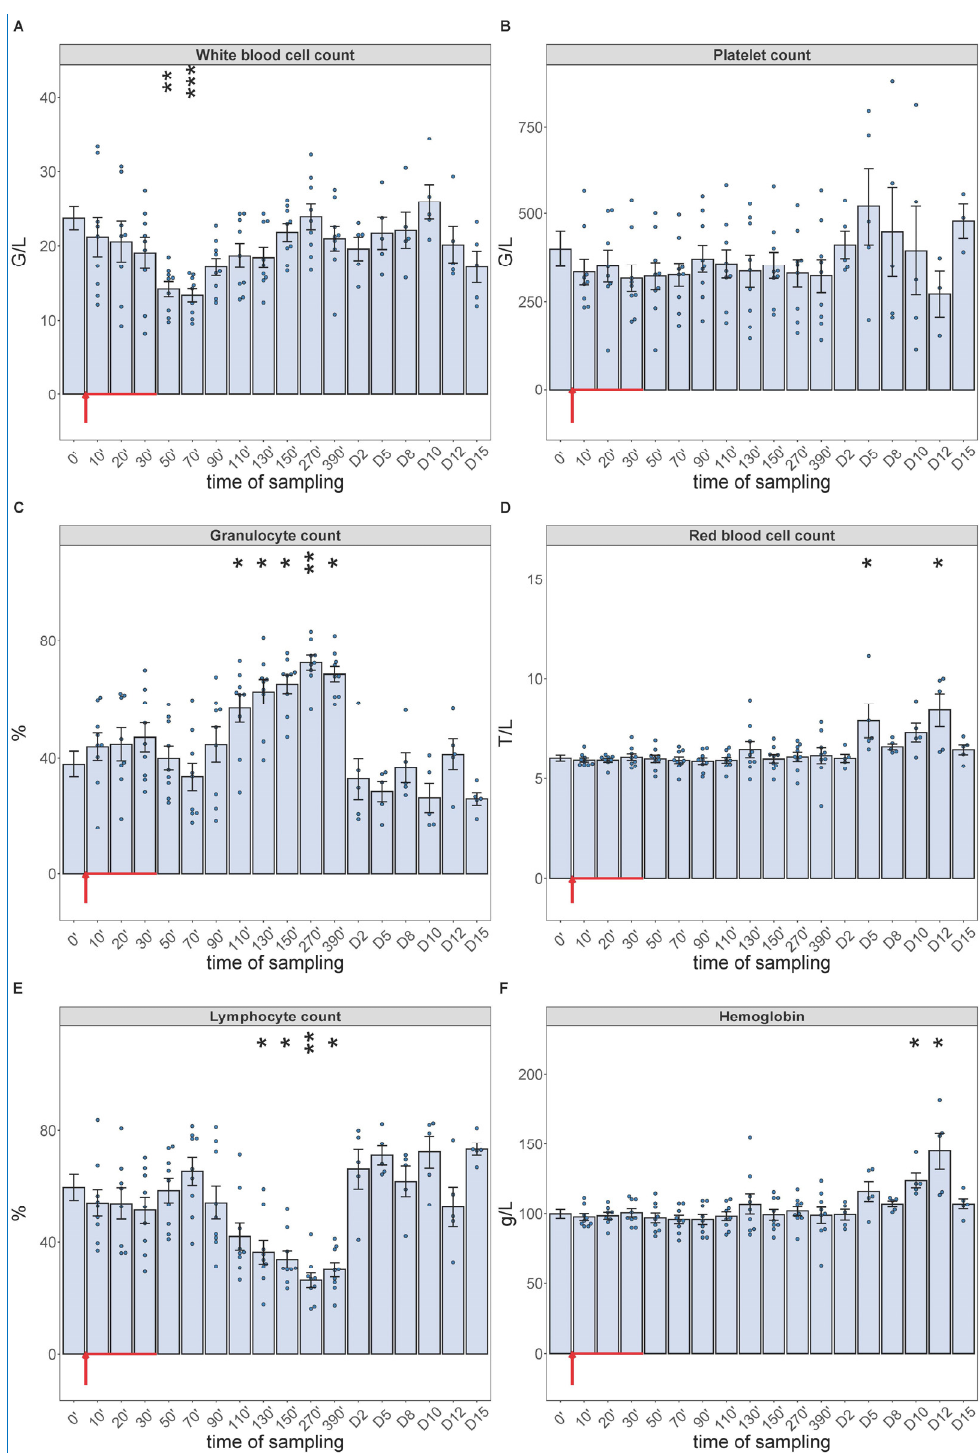
Figure 3. White blood cell count ( A ), platelet count ( B ), granulocyte % ( C ), RBC count ( D ), lympho- cyte % ( E ), hemoglobin levels ( F ) at different sampling times. Zymosan administration is marked with red arrow. Until 390 min, the data have been merged from the 2nd ( n = 4 pigs) and 3rd phase ( n = 5 pigs) of the study, and their overlapping excludes a pro-inflammatory influence of hemody- namic monitoring (surgery). Kruskal–Wallis test with Dunn’s multiple comparisons post-hoc test, compared to respective baseline (0’) controls, * p < 0.05 vs. 0’; ** p < 0.01 vs. 0’; *** p < 0.001 vs. 0’. Regarding the cytokine changes, the PCR assay showed significant expression of CCL-2 (Figure 4A), CXCL10 (B), IL-1RA (C) and IL-6 mRNAs in close parallelism with the